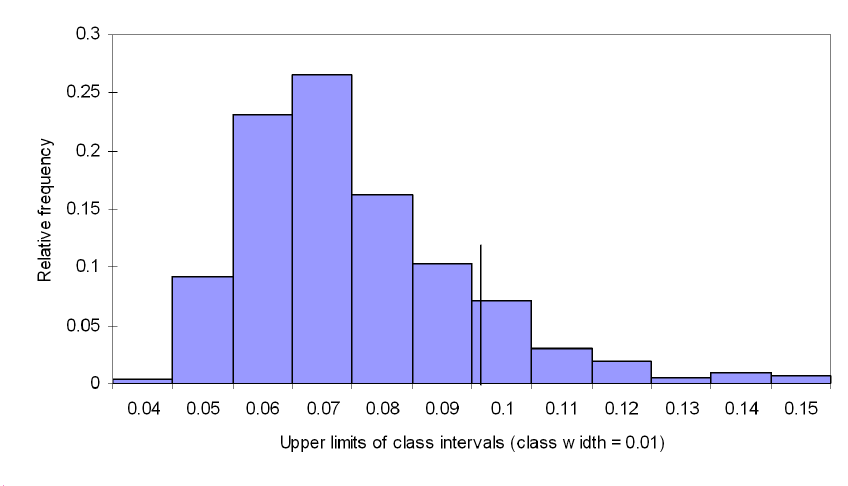
Figure 4: Histogram of largest AIC influence measures obtained in 10 000 bootstrap